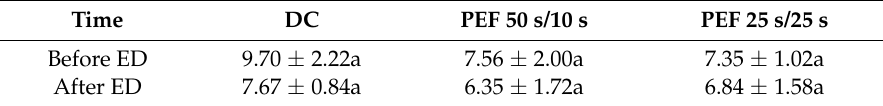
Table 1. Total protein content in whey in g/L, before and after electrodialysis.